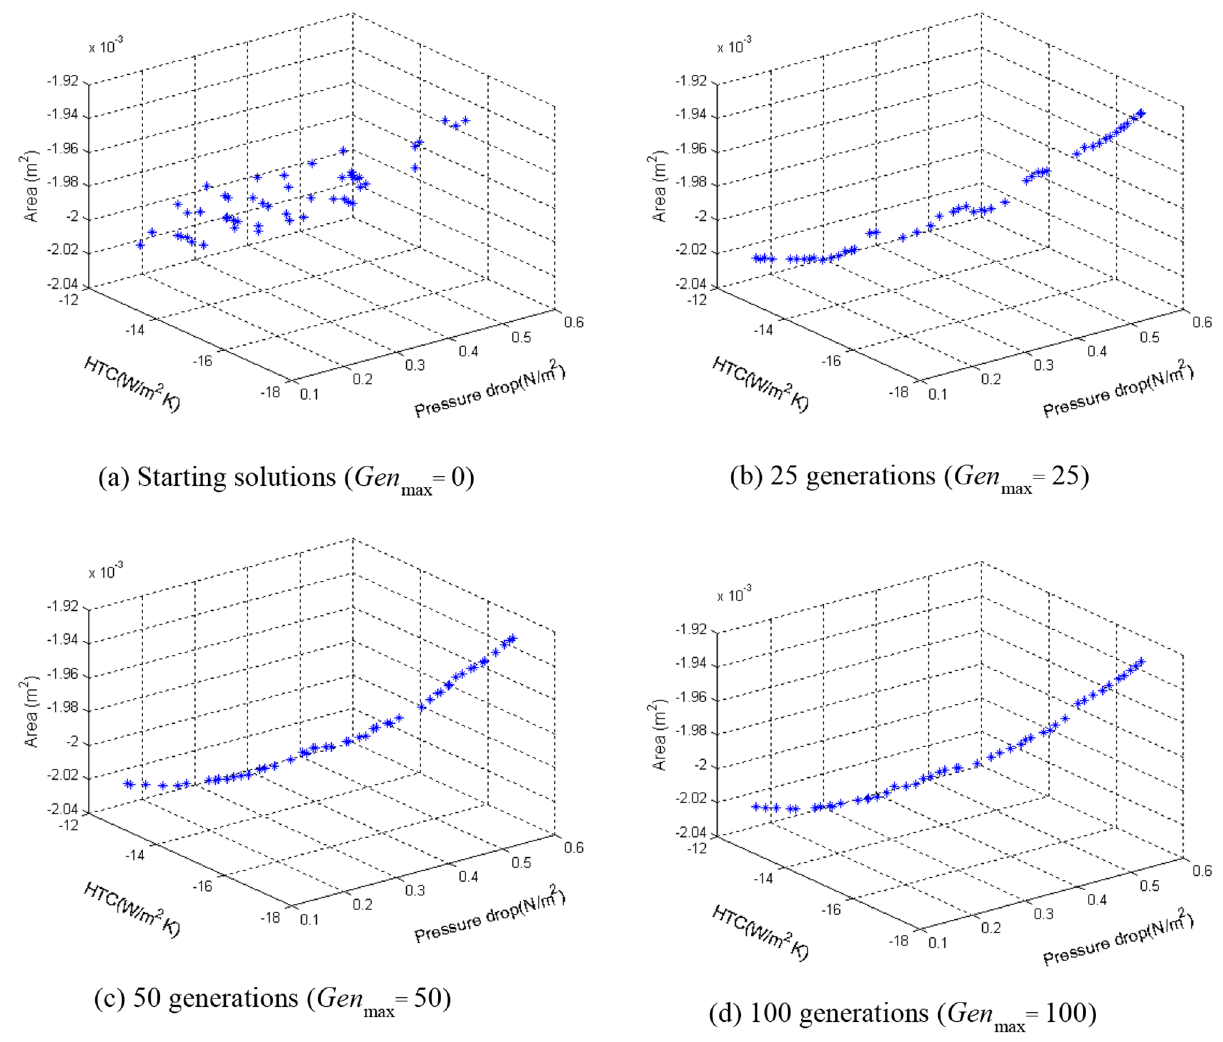
Fig. 9. Pareto optimal front of 3objectives and 4design